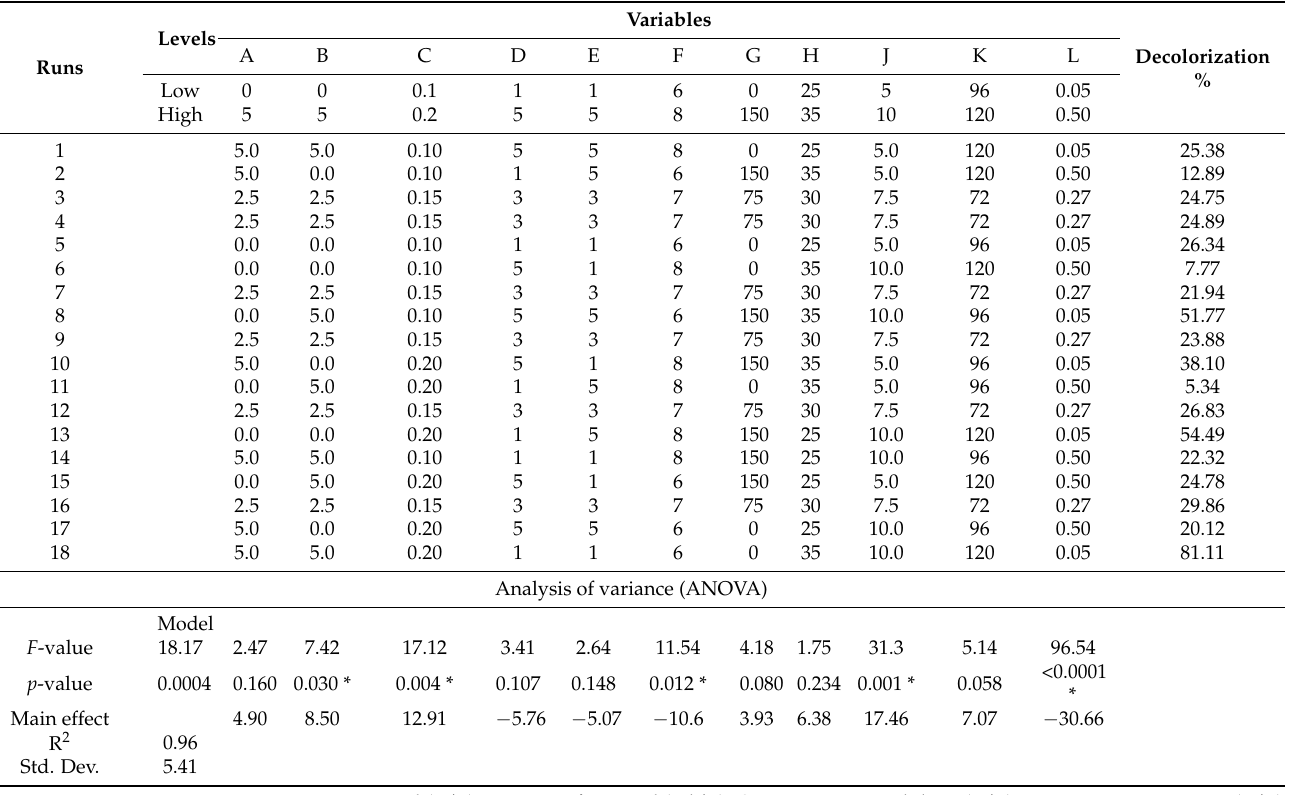
Table 2. PBD design matrix and ANOVA analysis against MG decolorization by S. exfoliatus